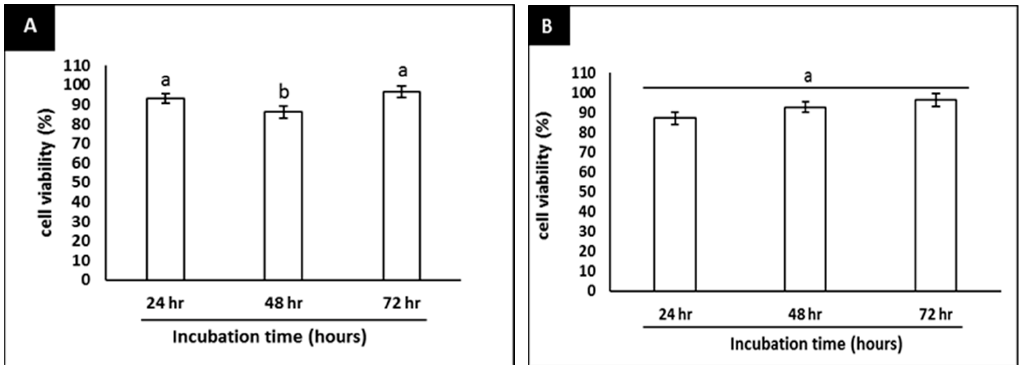
Figure 5. Neuroprotective e ff ect of 7-geranyloxycinnamic acid and curcumin (positive control) in time-dependent manner. ( A ) Represents means of 2.08 µ M 7-geranyloxycinnamic acid and exposed to H 2 O 2 (300 µ M) for 4 h. ( B ) Represents means of 5.97 µ M curcumin and exposed to H 2 O 2 (300 µ M) for 4 h. Data are displayed as means ± SD of triplicate experiments; means with di ff erent letters denote significant di ff erence ( p <